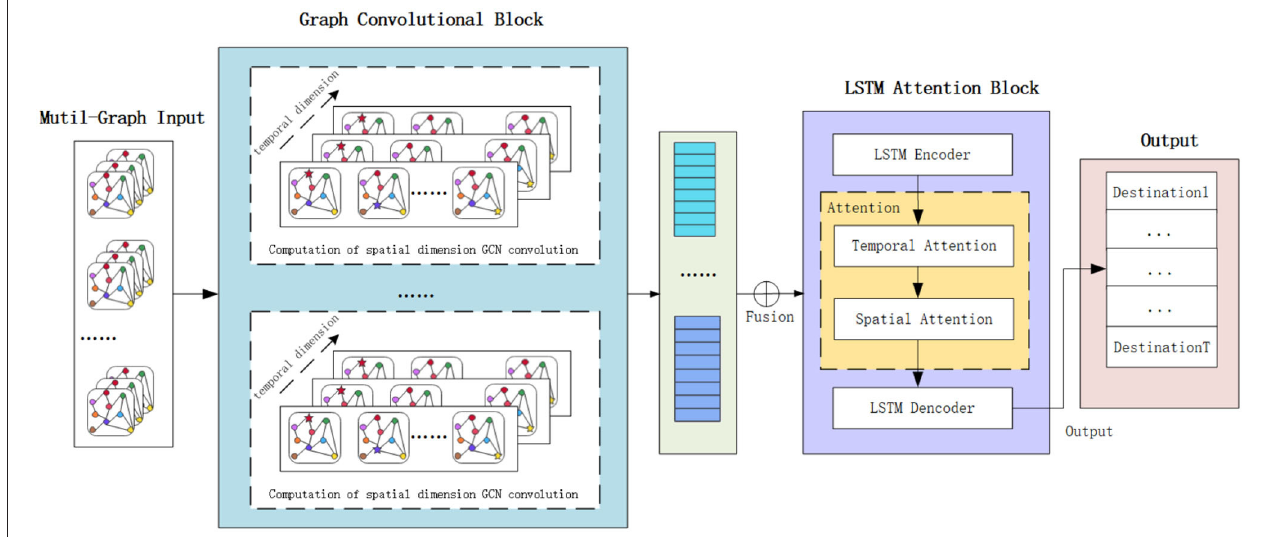
FIGURE 1 | The framework of the proposed Spatial-Temporal Attention and Graph Convolutional Network Model (STAGCN).